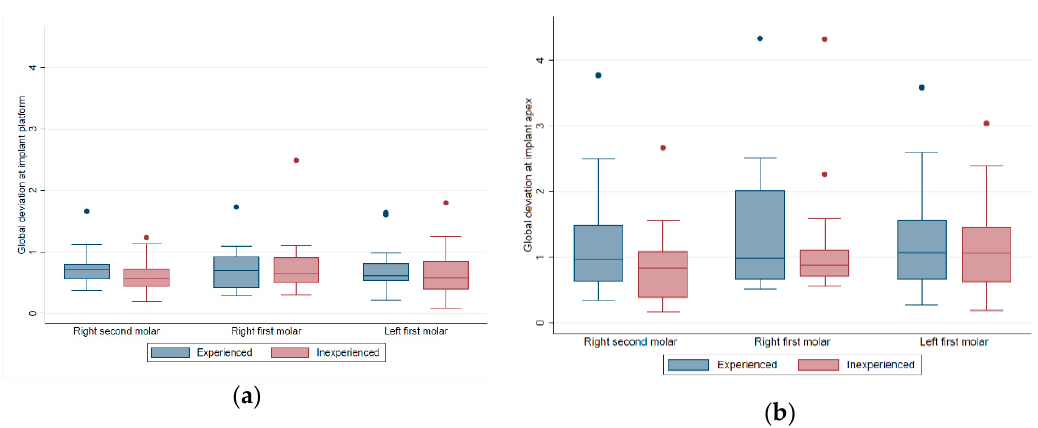
Figure 7. Box plots of the global deviation at implant: ( a ) platform and ( b ) apex of experienced and inexperienced operator group.